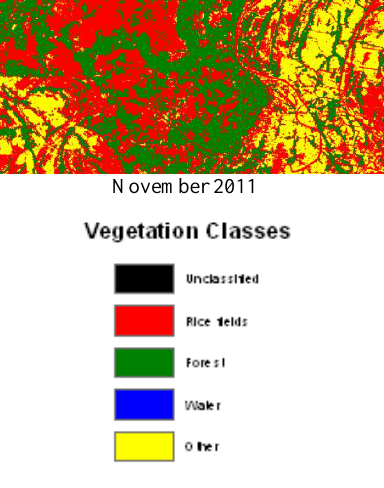
Figure 4: Top: ETM+ Classification, Middle: SAR Classification, Bottom: Fused ETM+ and SAR